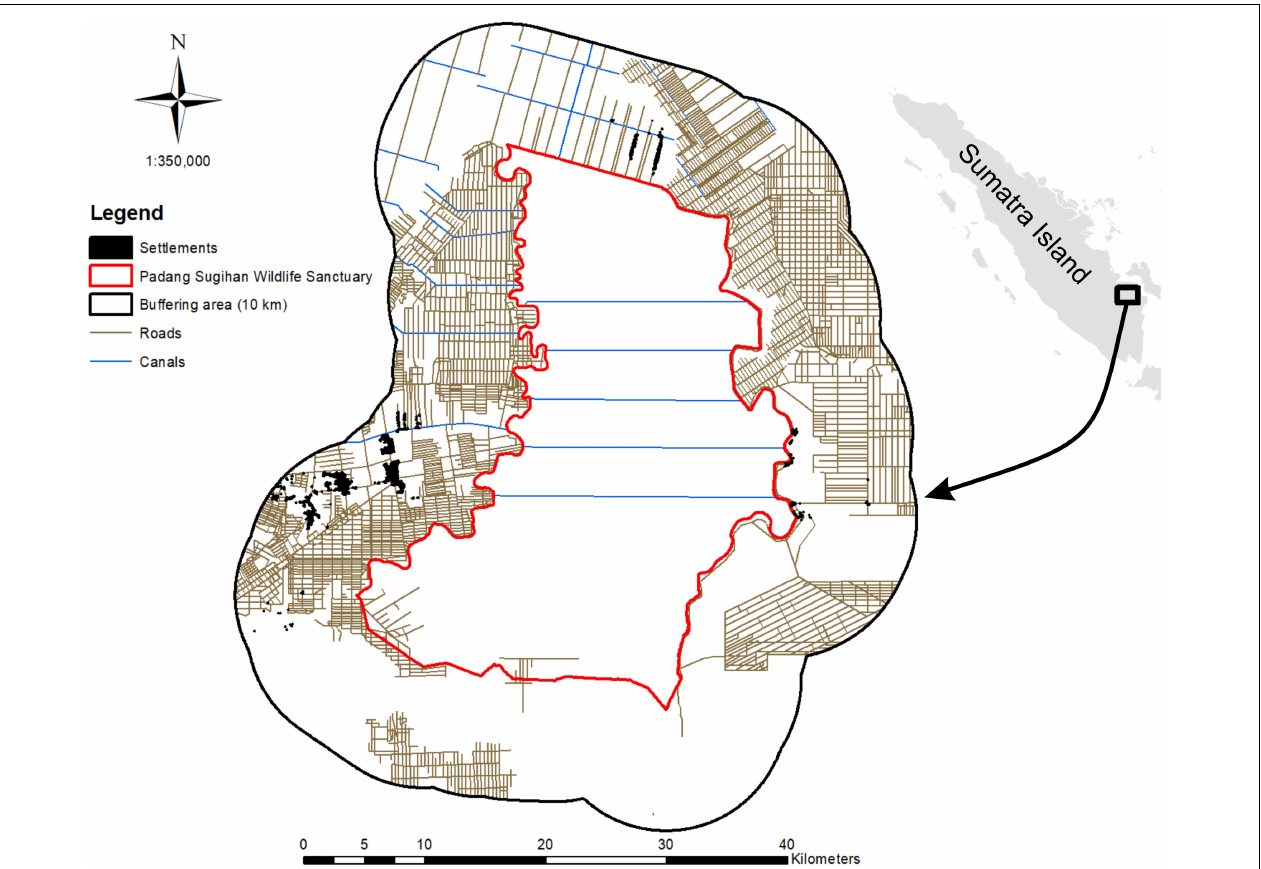
FIGURE 1 | Map of study area as of 2015, showing the canal and road networks within and surrounding Padang Sugihan Wildlife Reserve (PSWR) and the presence of settlements within a 10 km buffer of the reserve.